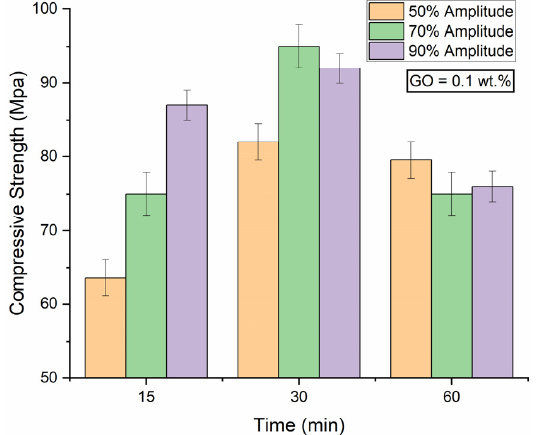
Figure 6. Compressive strength of 3D ‐ printed nanocomposite at varying amplitudes and times.